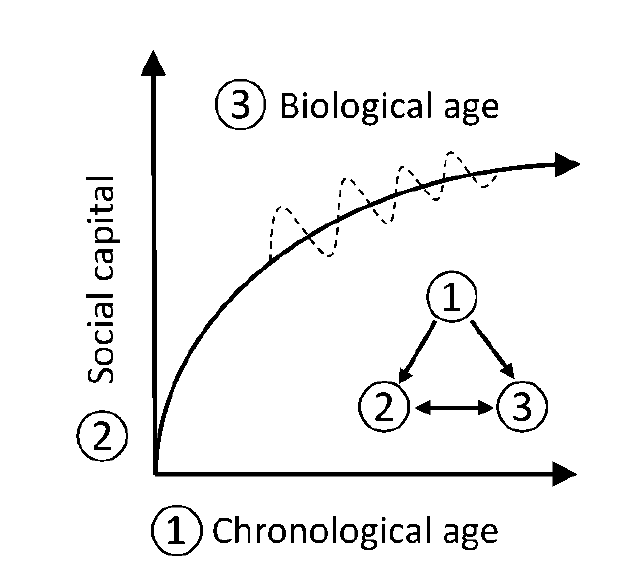
Figure 2: Changes in biological age (③, curved line) according to chronological age (①, x -axis) and social capital (②, y -axis). The dotted line represents variations observed in returning to a previous caste and solicitations in eusocial insects, but may result from intervention on social parameters in humans and other animals. The most recent research in animal species showed that biological age ③ is not only dependent on chronological age ① but also on social capital ② with an interplay between ② and ③. Interplay with ① cannot exist as chronological age cannot be